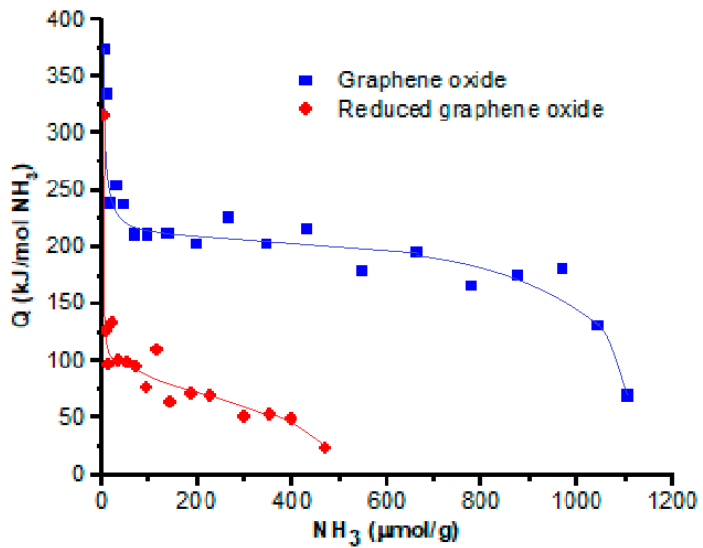
Figure 4. Calorimetry of NH 3 adsorption on GO and reGO .